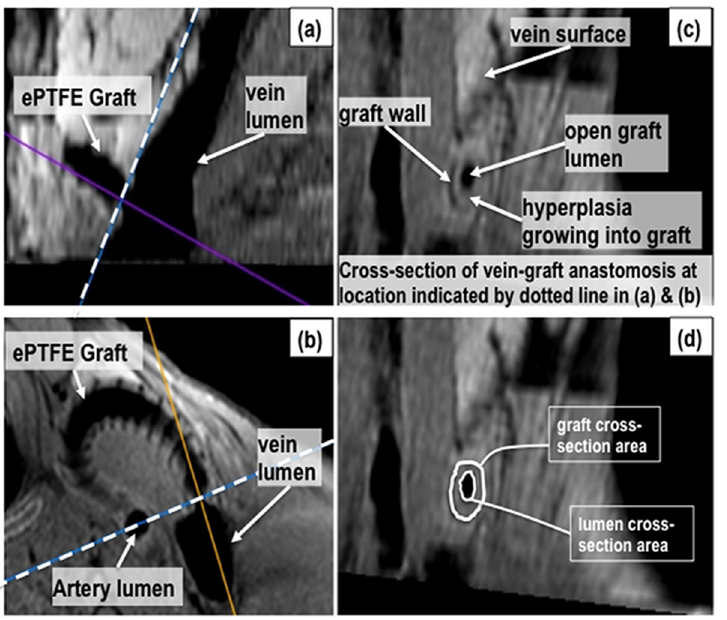
Fig 2. MRI analysis example. A multiplanar reconstruction of the 2D black-blood scan was performed on a pig with a graft placed between the common carotid artery and external jugular vein in the neck. The sagittal plane (a) and transverse plane (b) of the vein-graft anastomosis region were used to locate the cross-section with the smallest open lumen area at the vein-graft anastomosis (c). The graft wall and vessel lumens appear hypointense (black) in black-blood imaging. The spiral support around the graft is also hypointense and visible along the graft wall in (b). The face of the plane indicated by the dashed line in (a) and (b) is shown in (c). The lumen and graft cross-sectional areas were measured as shown in (d) using the region-of-interest pencil tool in Osirix.